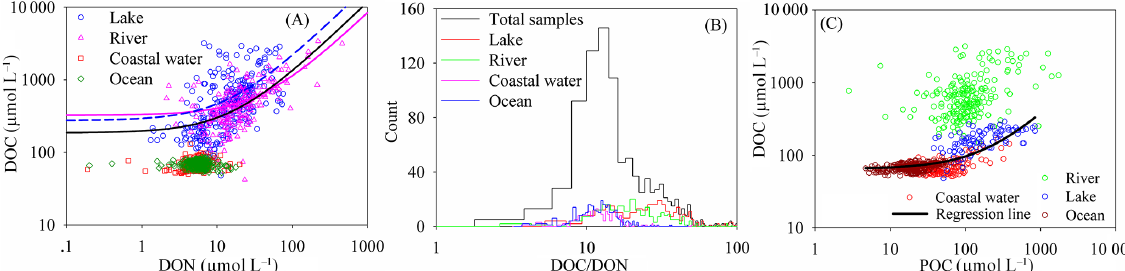
Figure 12. (a) Comparison of the relationships between DOC and DON for oceans, lakes, rivers, and coastal waters. The relation- ships between DOC and DON are DOC = 11 . 738 · DON + 165 . 41 ( R 2 = 0 . 35, n = 995, black solid line); DOC = 19 . 037 · DON + 273 . 59 ( R 2 = 0 . 20 , 288, blue dashed line); and DOC = 11 . 932 · DON + 234 . 36 ( R 2 = 0 . 61, n = 255, pink solid line) for all samples, in lakes and rivers, respectively. The correlation coefficients for DOC and DON are r = 0 . 44, 0.78, 0.15 and − 0 . 15 for lakes, rivers, coastal waters and oceans, respectively. (b) DOC / DON for oceans, lakes, rivers and coastal waters. The DOC / DON ratios are 24.10 ± 24.57, 40.43 ± 34.56, 29.35 ± 34.93, 13.15 ± 4.95 and 12.86 ± 4.88 for all samples, lakes, rivers, coastal waters and oceans, respectively. The corresponding POC / PON ratios are 9.65 ± 16.73, 7.71 ± 0.61, 7.07 ± 2.44 and 6.24 ± 1.20 for lakes, rivers, coastal waters and oceans, respectively. (c) Re- lationships of POC and DOC for different water types. The correlation between POC and DOC is weak for individual water types, but is strong for the combined data of lakes, oceans and coastal waters. The regression function (black line in the figure) between POC and DOC is DOC = 0 . 315 · POC + 64 . 88 ( R 2 = 0 . 58, n = 570), not including river